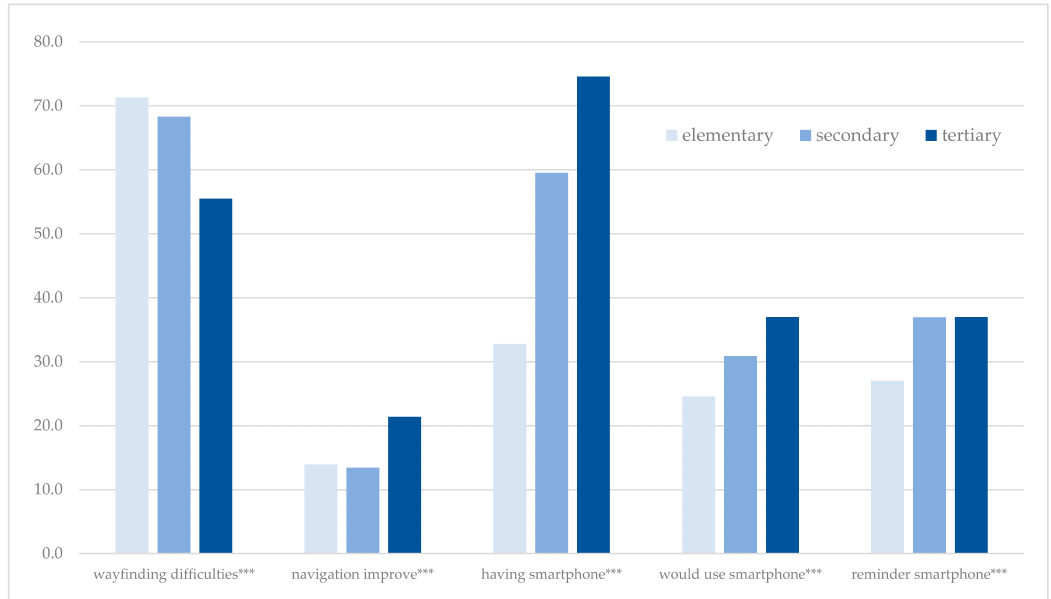
Figure 3. Education and opinions of the respondents: share of positive answers (%). Source: The Authors. Note: variables significantly related to the education are marked: * p < 0.05; ** p < 0.01; *** p < 0.001.